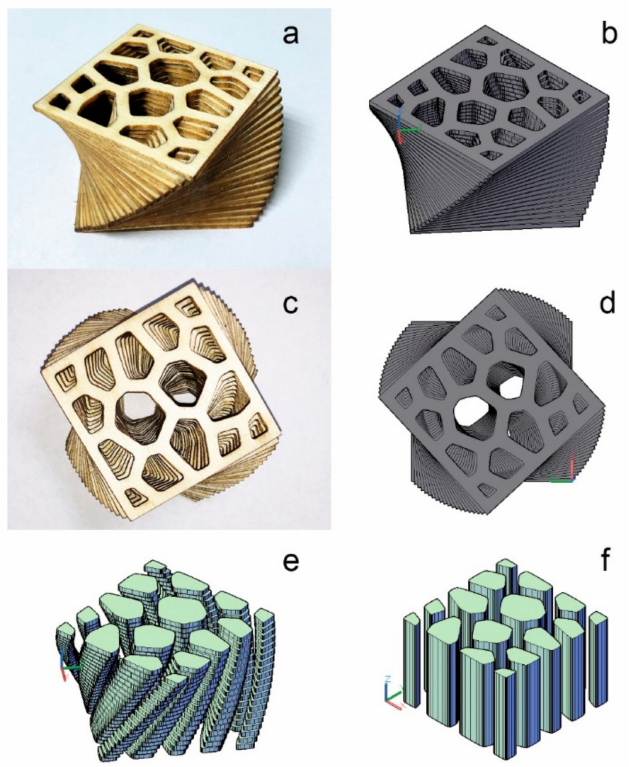
Figure 4. Comparison between the laser-cut veneer lamination (LcVL) product and its 3D model. ( a ) Orthographic view of the LcVL product; ( b ) Orthographic view of the 3D model of the product; ( c ) Top view of the LcVL product; ( d ) Top view of the 3D model of the product; ( e ) Tubular voids present in the 3D model of the product postrotation; ( f ) Tubular voids present in the 3D model of the product